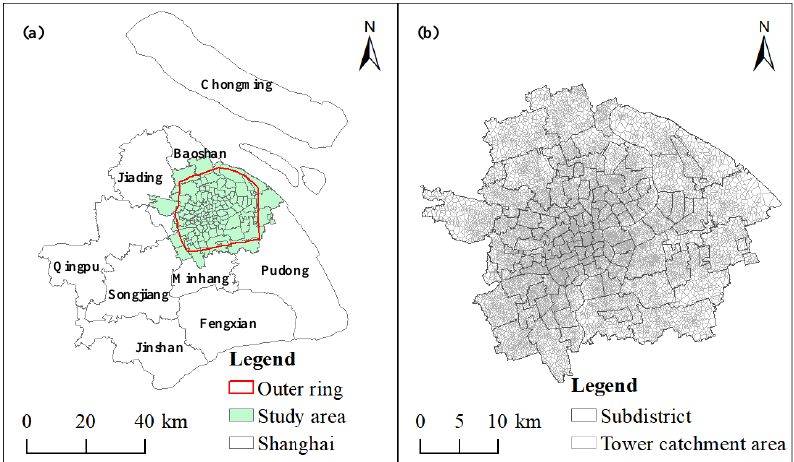
Figure 1. Maps of ( a ) Shanghai and ( b ) the study area.